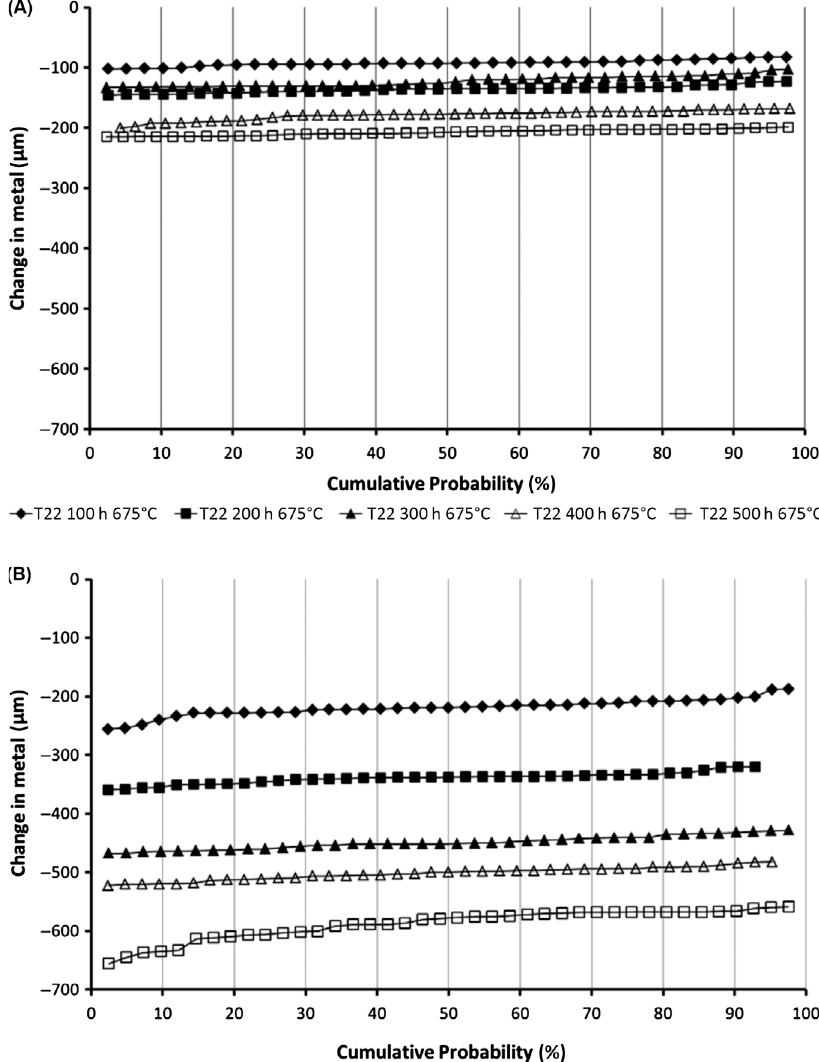
Figure 8: Change in metal vs cumulative probability showing metal loss data of T22 alloy (A and B) and T23 alloy (C and D) after exposure at 675°C and